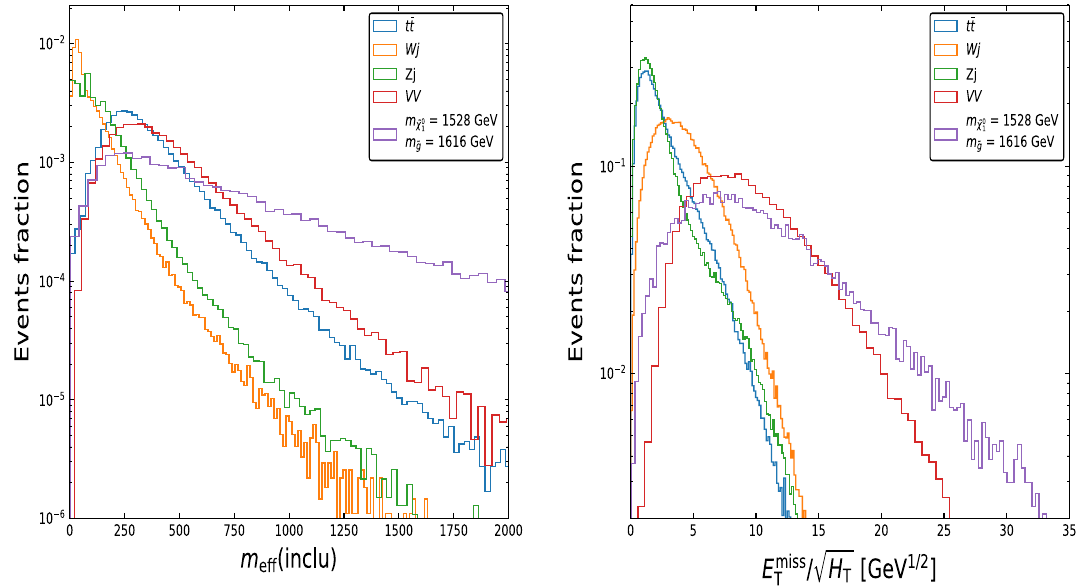
√ / H T for the signal and background events at the HE-LHC. The benchmark point T